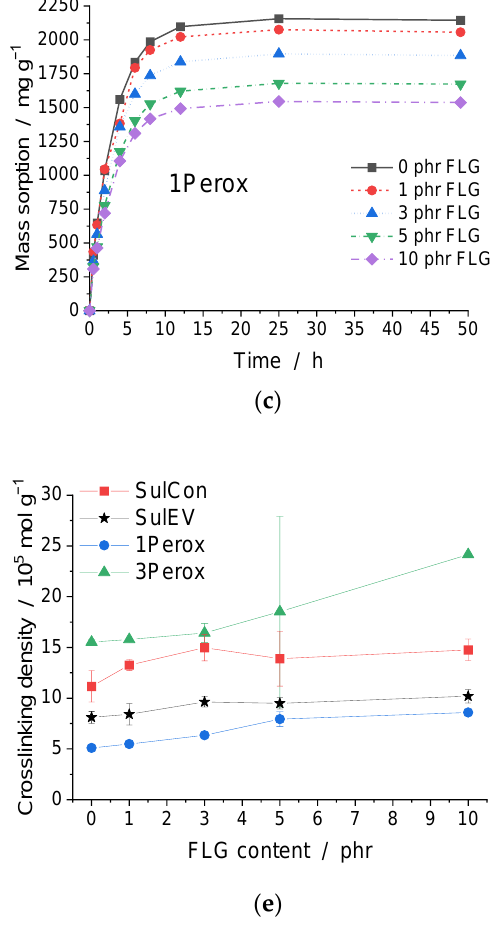
Figure 3. Development of the mass sorption over time shown for ( a ) SulCon, ( b ) SulEV, ( c ) 1Perox, and ( d ) 3Perox; ( e ) shows the crosslinking density over FLG